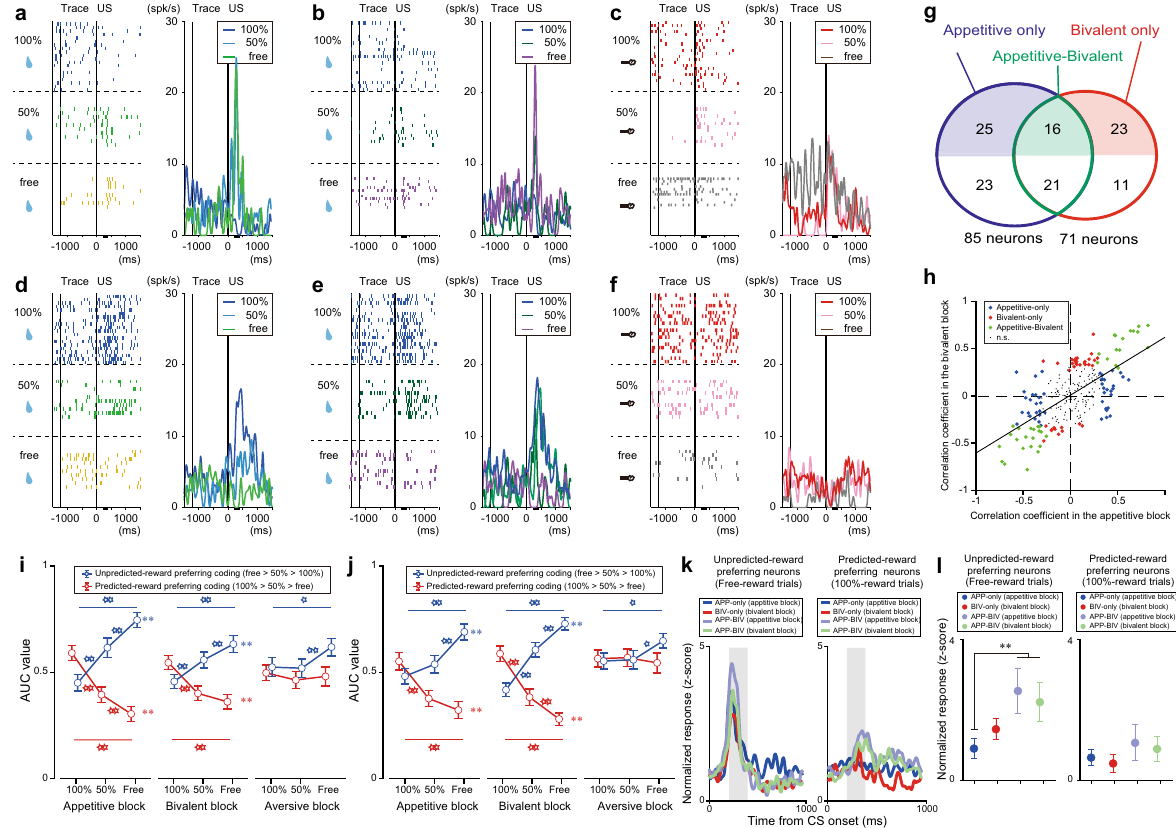
Figure 3. Reward predictability-coding neurons in the lateral hypothalamus. ( a–f ) Representative responses of an unpredicted reward-preferring neuron in the appetitive ( a ), bivalent ( b ), and aversive ( c ) blocks in the rasters ( left ) and histograms ( right ) and a predicted reward-preferring neuron in the appetitive ( d ), bivalent ( e ), and aversive ( f ) blocks. US, unconditioned stimulus. ( g ) Number of reward predictability-coding neurons in the appetitive and bivalent blocks. The labels indicate the reward predictability-coding types (appetitive-only type: blue; bivalent-only type: red; appetitive-bivalent type: green). Colored and white areas depict the unpredicted and predicted reward-preferring neurons, respectively. h ) Consistent sensitivity of reward predictability between the appetitive and bivalent blocks ( p = 2.65 –24 , ρ = 0.59, Spearman’s correlation test). Each dot indicates a single lateral hypothalamus neuron. The same dot colors as in g were used to depict neuron types. ( i–j ) Preferred responses of reward predictability-coding neurons classified by their reward-predictability responses in the appetitive ( i ) or bivalent ( j ) blocks. The responses were indexed by the area under the curve value (AUC) during the test window (201–400 ms after US delivery) relative to the responses for the last 500 ms before timing cue (TC) onset (* p < 0.05/3, ** p < 0.01/3, Wilcoxon signed-rank test with Bonferroni’s correction; ** p < 0.01, Spearman’s correlation test). ( k–l ) Larger response modulation of the appetitive-bivalent (APP-BIV) type than that of the appetitive-only (APP-only) and bivalent-only (BIV-only) type ( k ) for the unpredicted reward- preferring neurons ( left ) and mean values during 201–400 ms after US onset (gray areas in k) for the positive ( left ) and negative ( right ) types ( l ). Normalized activity ( z -score) in the free-reward trials was compared between the blocks for the unpredicted reward-preferring type ( left ), and that in the 100% trials was compared for the predicted reward-preferring type ( right ). ** p < 0.05, one-way ANOVA and post-hoc Fisher’s least significant difference test. The same conventions are used as in Fig.